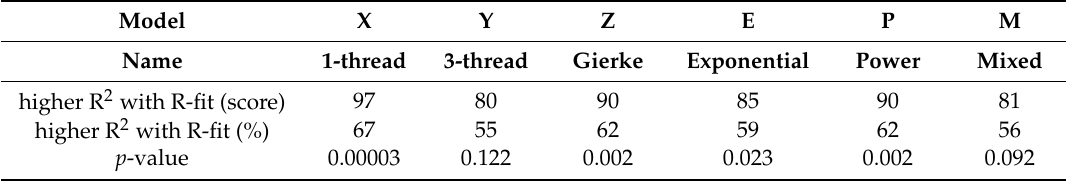
Table 7. Comparison of R 2 values of two regression methods. Listed are numbers and percentages for which the coe ffi cient of determination (R 2 ) of the resistance plot was higher than the R 2 of the conductivity plot. The last row indicates the p -value of the sign test. Model X Y Z E P M Name 1-thread 3-thread Gierke Exponential Power Mixed higher R 2 with R-fit (score)